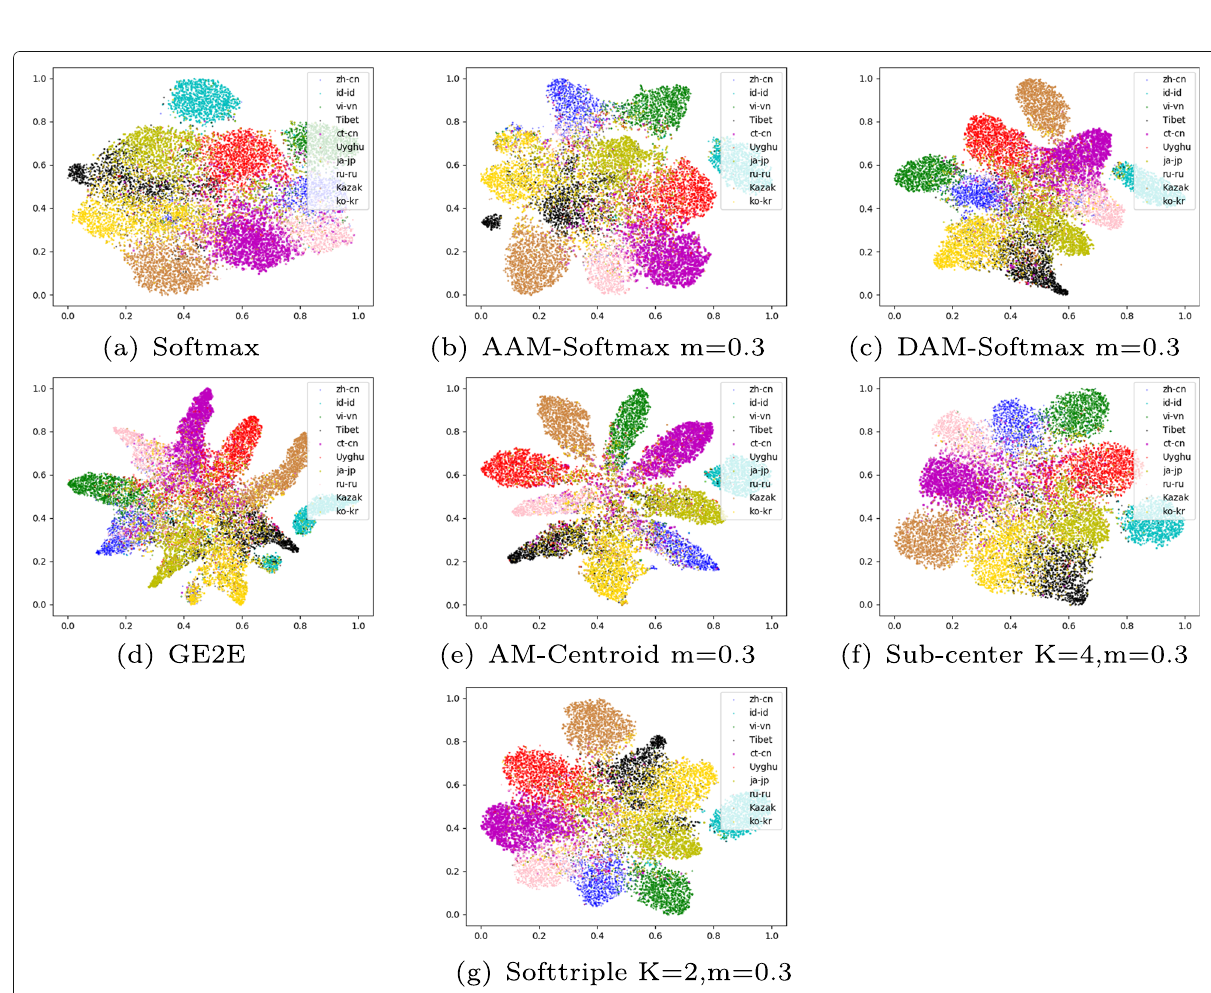
Fig. 8 Language embeddings of the baselines are plotted by t-SNE, under test-1s on AP17-OLR. Each shape/color represents a different language. a EER=11.35, C avg =11.05, min DCF=11.09. b EER=10.17, C avg =9.76, min DCF=10.04. c EER=9.44, C avg =8.76, min DCF=9.09. d EER=14.23, C avg =13.56, min DCF=13.73. e EER=13.27, C avg =12.12, min DCF=12.66. f EER=9.13, C avg =8.69, min DCF=9.19. g EER=9.05, C avg =8.54, min